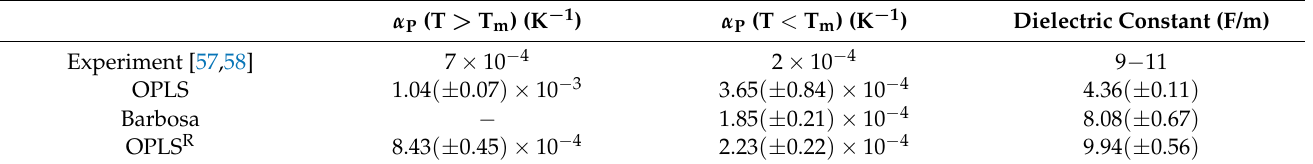
Figure 4. Thermal expansion coefficient of pure PEO system versus temperature. The black circles are the results of the OPLS model, the red squares and green triangles correspond to the Barbosa and the OPLS R models, respectively. The cyan and orange dashed lines represent the experimental results in low and high-temperature regions, respectively. The dotted lines are the guiding sigmoidal curves fitted with logistic functions. Table 1. Thermal expansion coefficient α P above and below T m and the dielectric constant evaluated at 298 K for the PEO melt systems in the three tested force fields compared with experimental values (data from